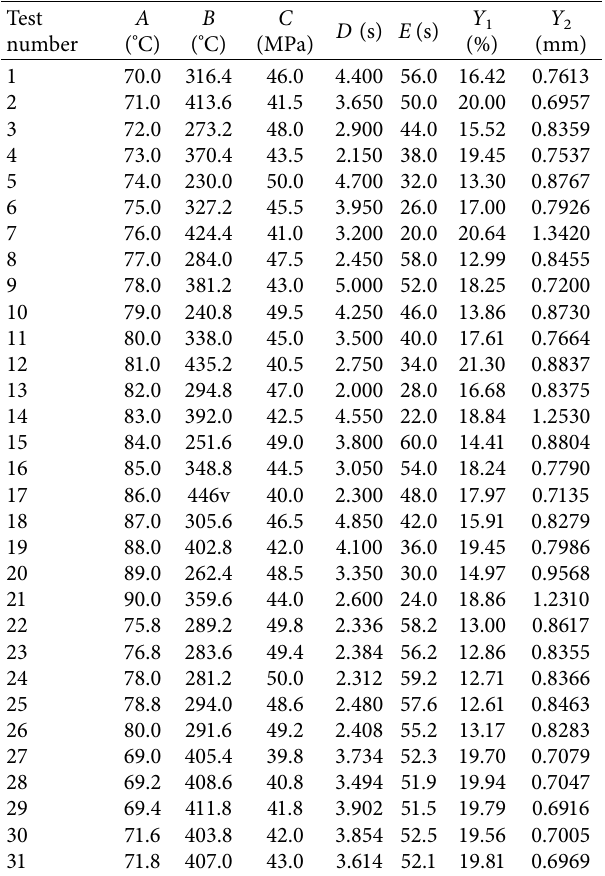
Table 15: Test data sheet.